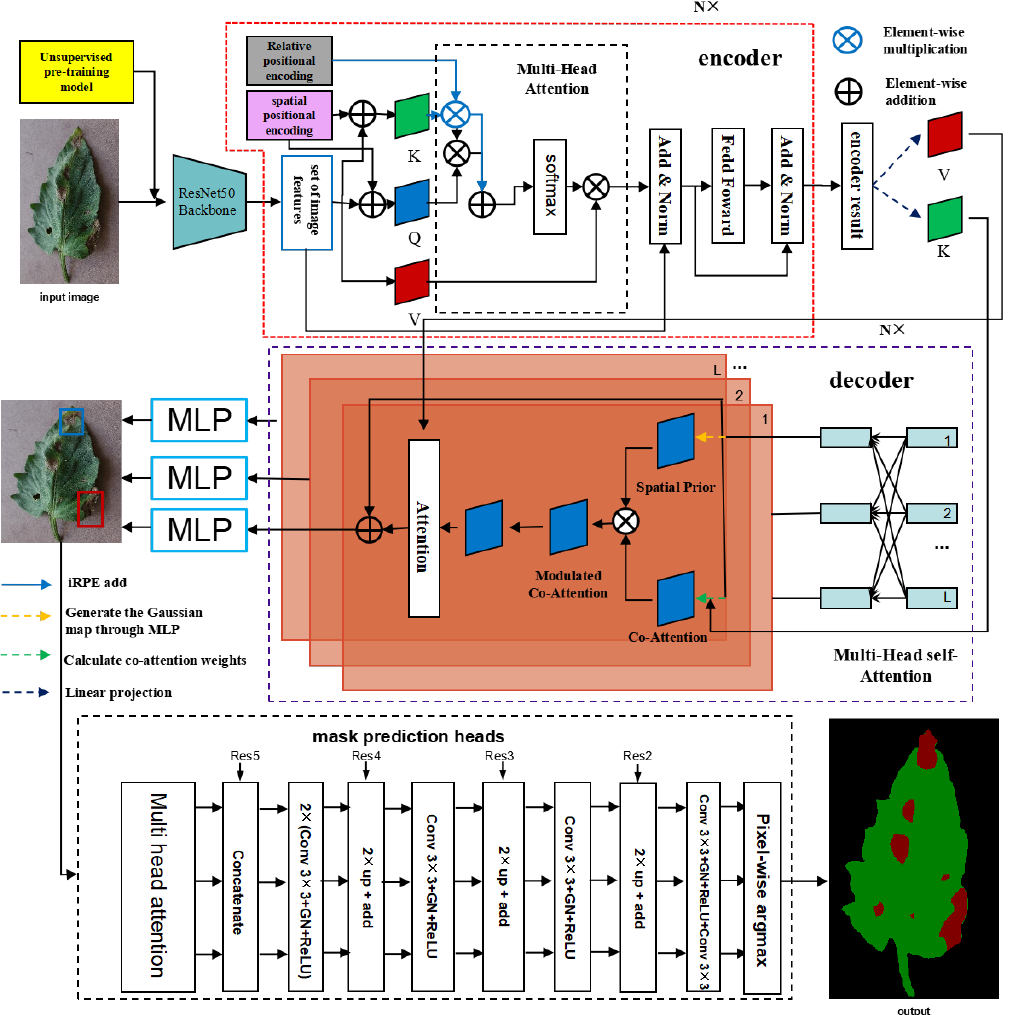
Figure 3. The schematic layout of the DS-DETR with backbone, unsupervised pre-training weight, encoder (including position encoding, multi-head self-attention), decoder (including multi-self-attention and spatial module), detect prediction head, and mask prediction heads.